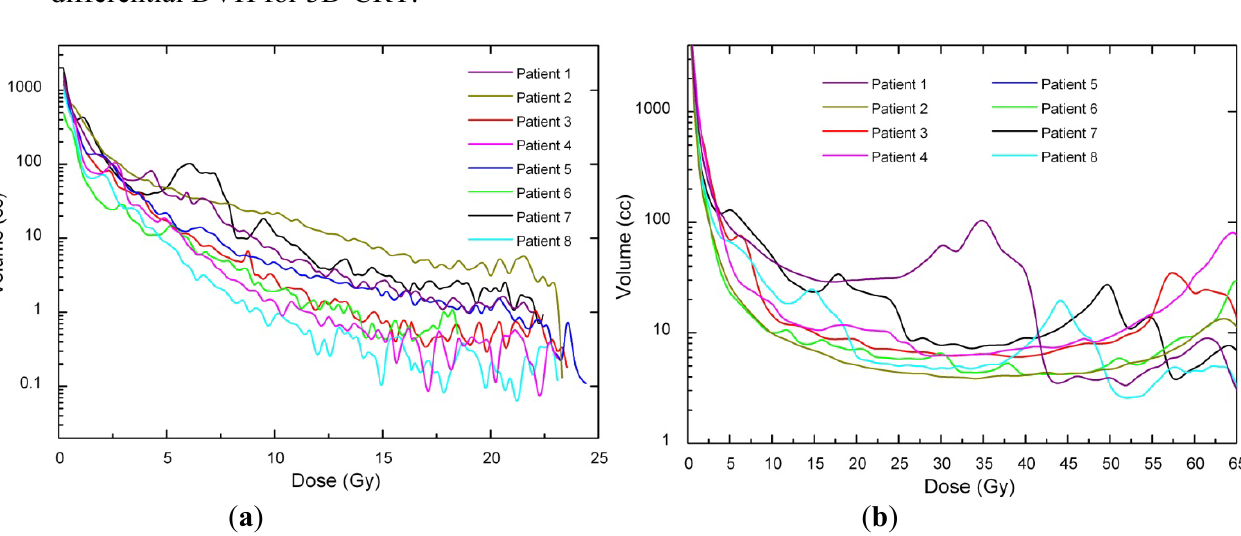
Figure 1. ( a ) Non tumor tissue differential DVH for SBRT. ( b ) Non tumor tissue differential DVH for